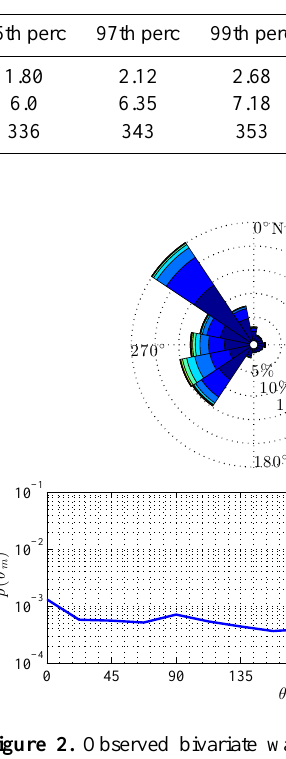
Figure 1. Acqua Alta (AA) oceanographic tower location in the northern Adriatic Sea, Italy (left panel). The tower is depicted in the right panel. Table 1. Wave climate at Acqua Alta in the period 1979–2008. Mean ( (cid:104)−(cid:105) ), standard deviation (SD), minimum (min), n th percentile ( n th perc), and maximum (max) of wave parameters.